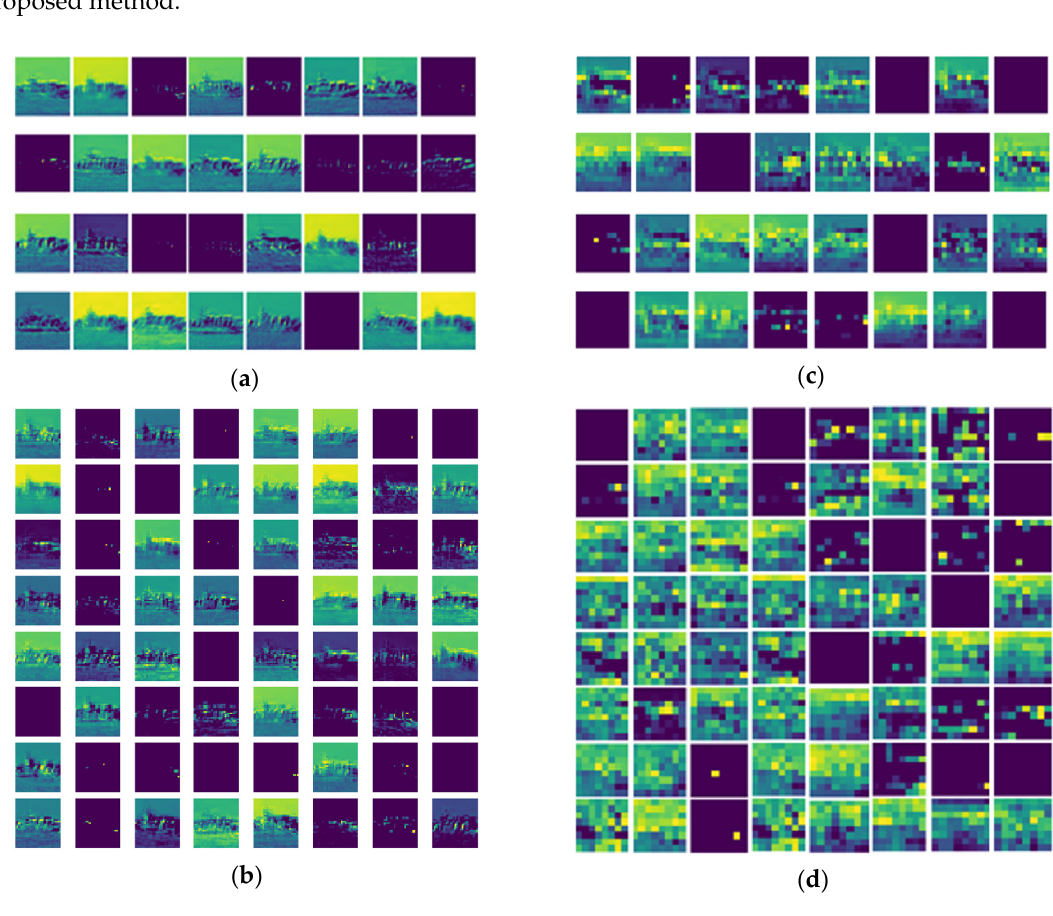
Figure 3. Classification accuracy (%) of each ship class corresponding to four cases listed in Table 1.